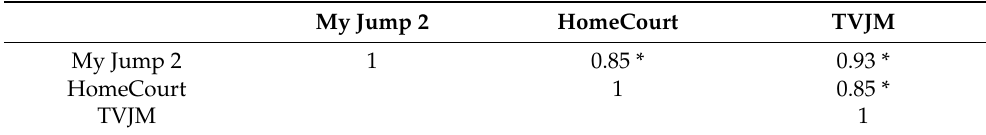
Table 2. Pearson’s correlations among devices of My Jump 2, HomeCourt, and